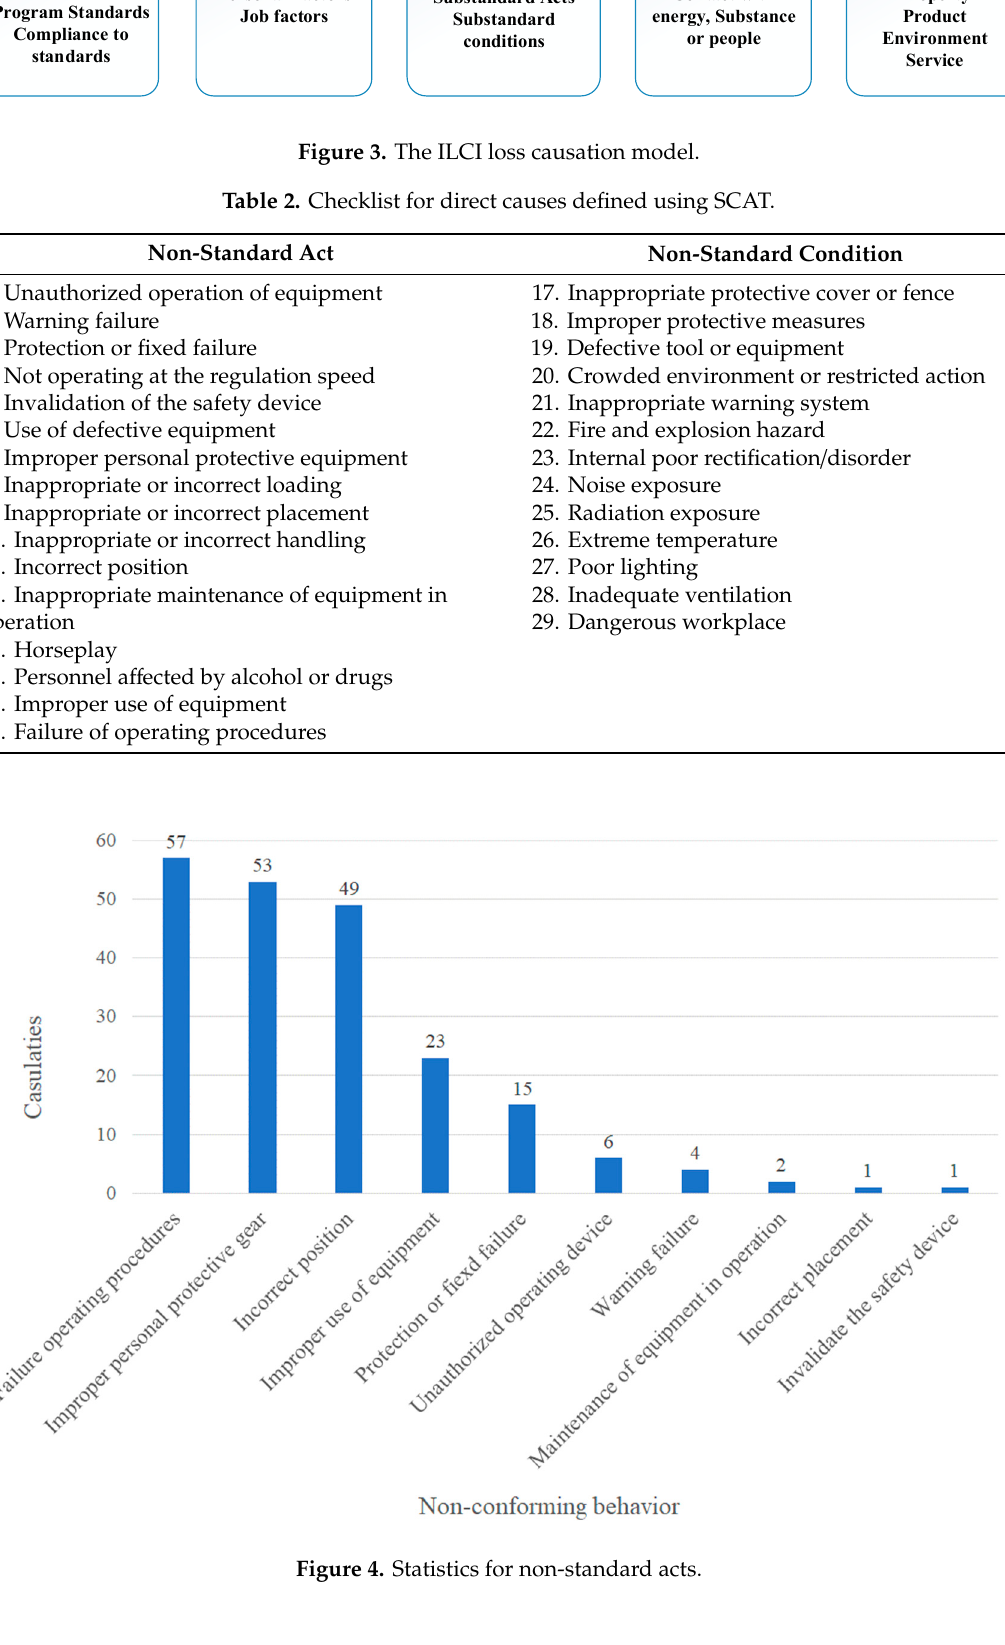
Figure 5. Statistics for non-standard conditions. 3. Results and Discussion 3.1. Characterization of Fatal Work Accidents in Confined Spaces in Taiwan In this study, consolidation analysis was conducted according to the 64 accident reports associated with confined spaces published by OSHA (Taiwan). Relevant analysis results were as follows.